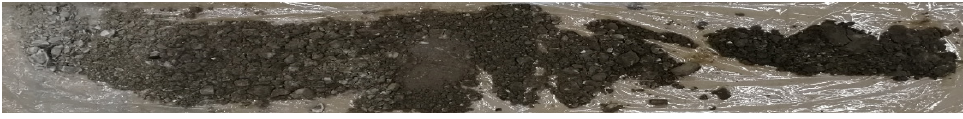
Figure A7. Oil sands after one-dimensional flooding.